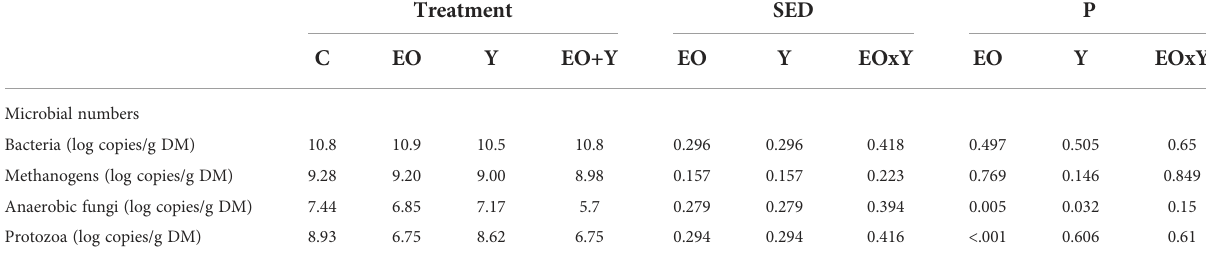
TABLE 3 Effect of supplementing a control diet (C) with oregano oil (EO), yeast (Y) or a combination of both (EO+Y) on microbial numbers in the RUSITEC system. Treatment